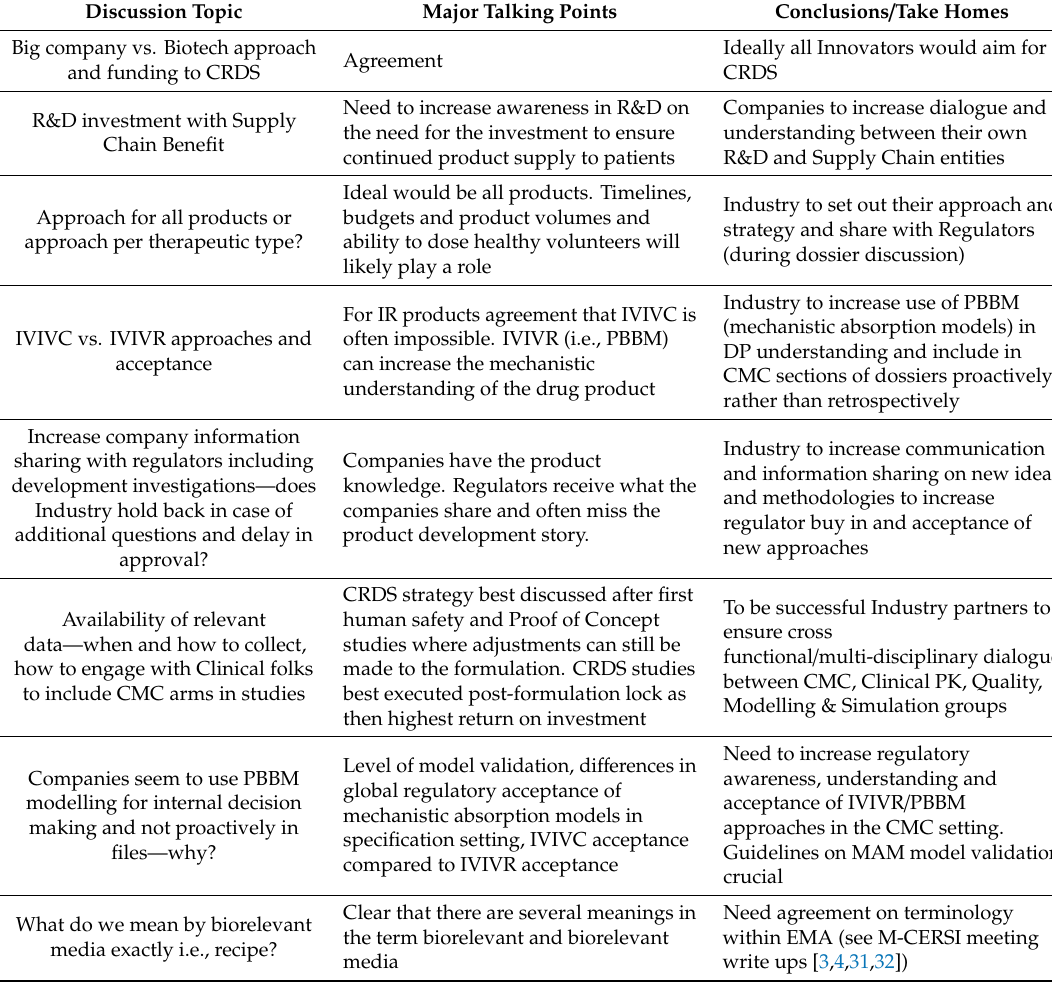
Table 2. Round Table Discussion: Topics, Major Talking Points and Conclusions / Take Home Messages. Discussion